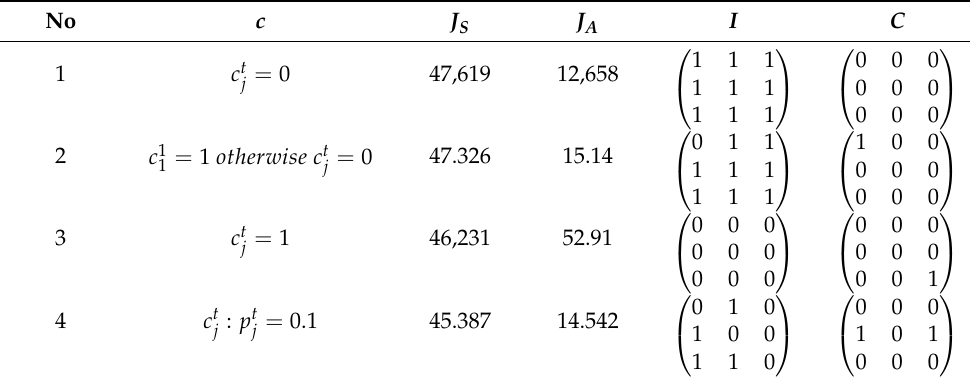
Table 4. Players’ optimal strategies and payoffs in dependence of the audit